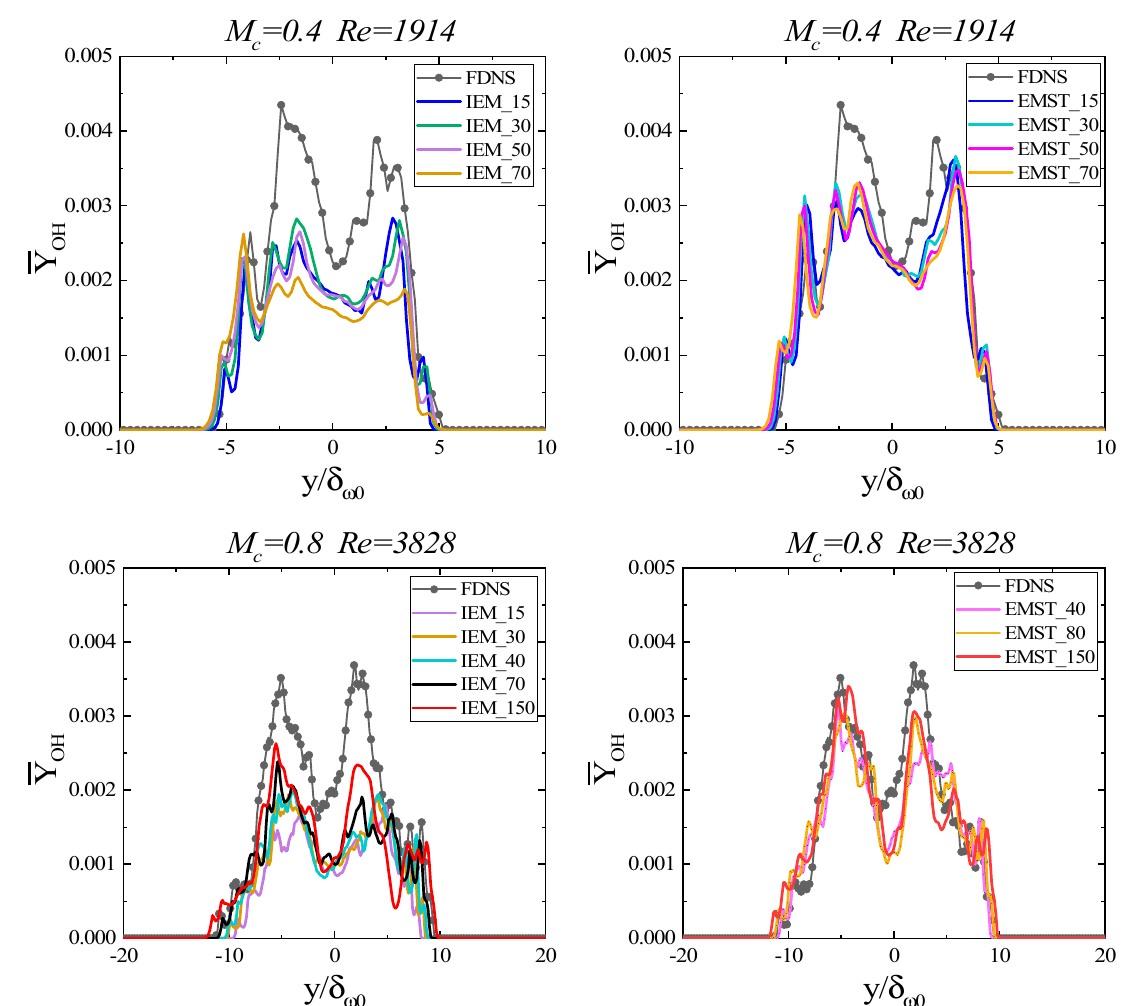
Figure A1. Cross-stream profiles of Reynolds-averaged values of the product mass fraction under different C (cid:2990) : mass fraction calculated by FMDF-IEM for M c = 0.4 case, mass fraction calculated by FMDF-EMST for M c = 0.4 case, mass fraction calculated by FMDF-IEM for M c = 0.8 case, mass fraction calculated by FMDF-IEM for M c = 0.8 case.